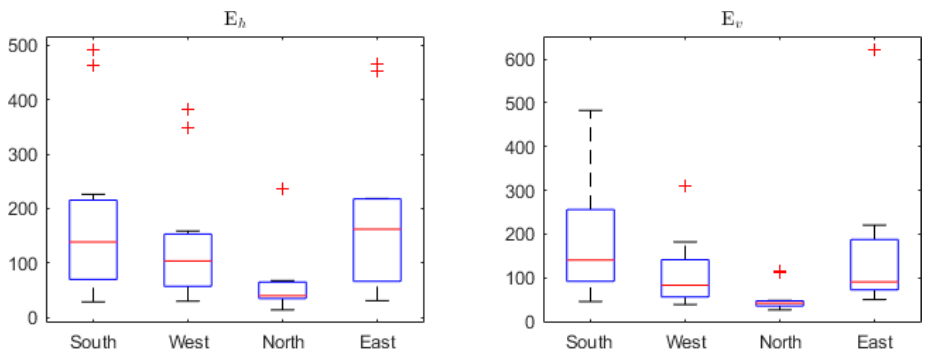
Figure A2. Root mean square error distribution of horizontal illumination (Eh, left) and vertical illumination (Ev, right). Both are generated based on the weather file with different conditions.